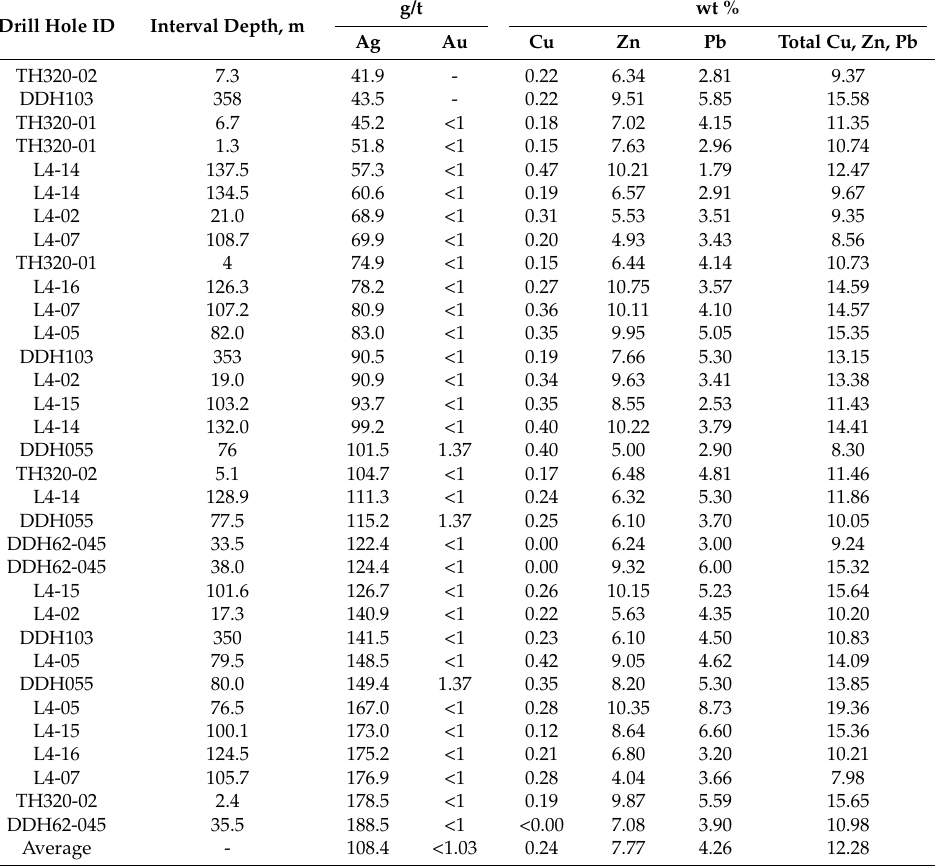
Table 2. Lens 4 drill core interval assay